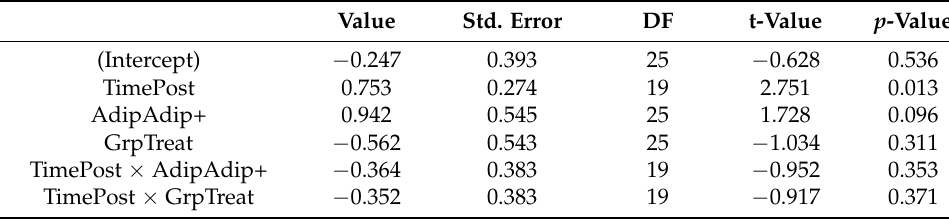
Table 8. LME parameters fitted to the limb-strength score (PC2, LS) of Study